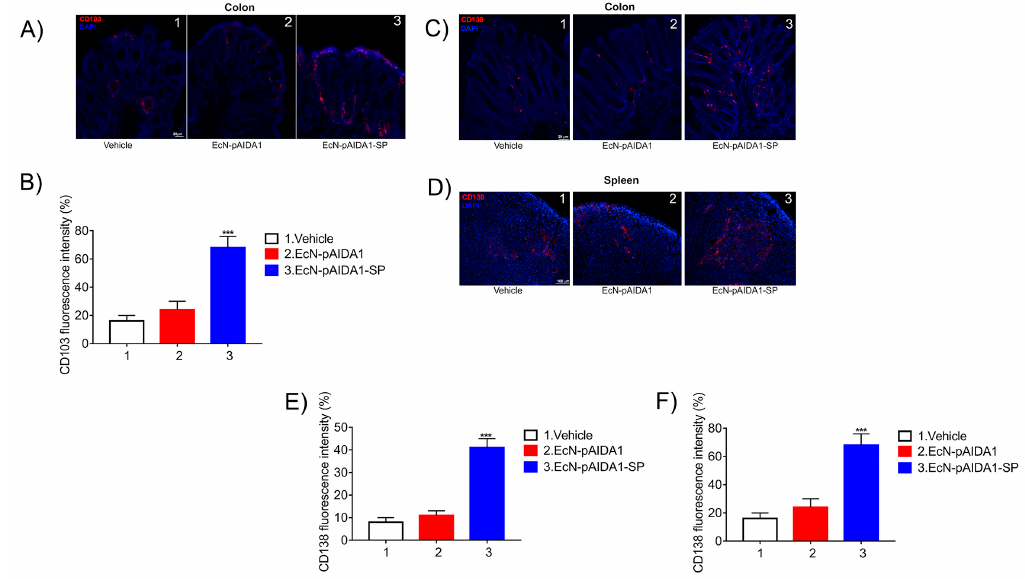
Figure 5. Immunofluorescence staining and their respective quantification corresponding to ( A , B ) CD103 and ( C – F ) CD138 at the colon and spleen sites, showing the effects of the EcN-pAIDA1-SP on mucosal dendritic cells in the gut ( A ) and on plasma cell population in the colonic mucosa and at the spleen site. All the samples of EcN-pAISA1-SP immunized group, EcN-pAIDA1 group, and control group were collected at week 16. Nuclei were stained using Hoechst staining. Results are expressed as mean ± SD of n = 5 experiments performed in triplicate. *** p < 0.001 vs. control. Scale bar = 20 μ m ( A , C ); 100 μ m ( D ).